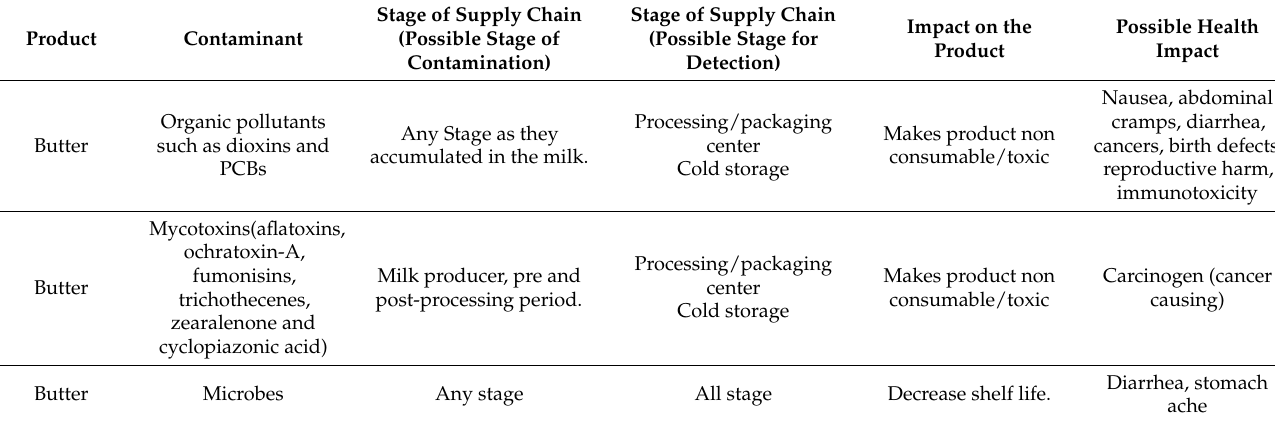
Table A5. Type of contaminants in butter and their impacts on health and